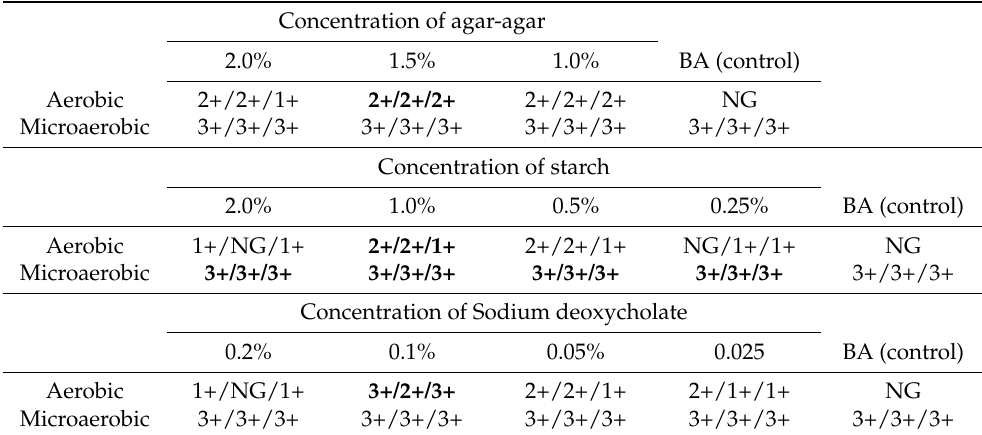
Table 1. Qualitative growth of C. jejuni ATCC 33560 T incubated under aerobic or microaerobic conditions. Concentration of agar-agar 2.0%